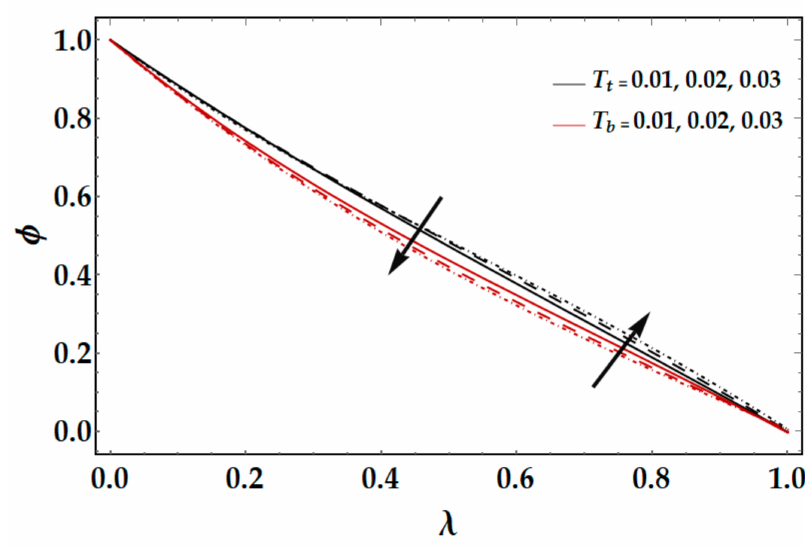
Figure 10. Implications of T t and T b on concentration function φ ( λ ) .